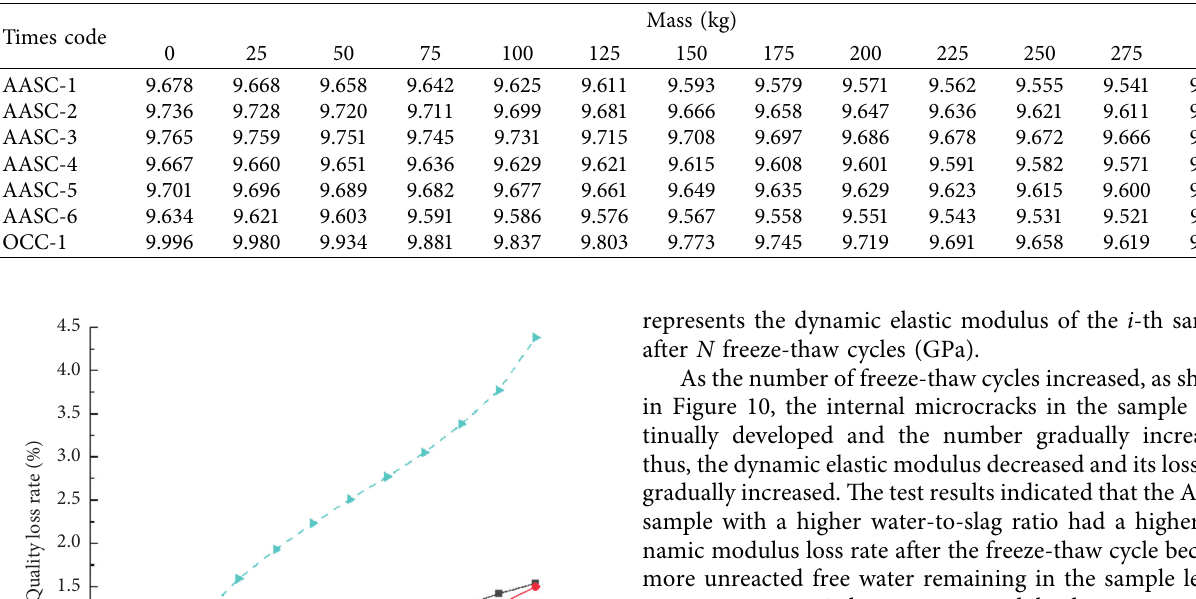
Table 5: Mass of the prism samples after different freeze-thaw cycles.